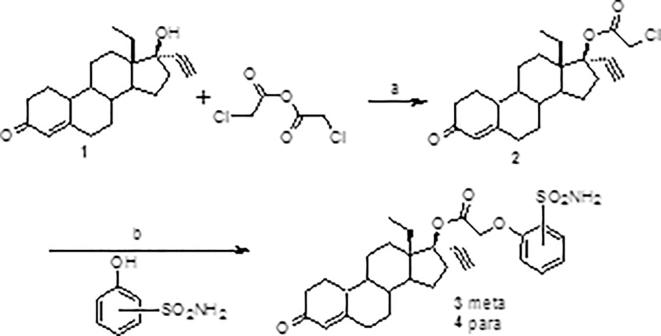
Synthesis of LNG-sulfamoylphenoxyacetic acid esters: (a) DMAP, toluene, reflux, 16 h; (b) Cs2CO3, DMF, rt.